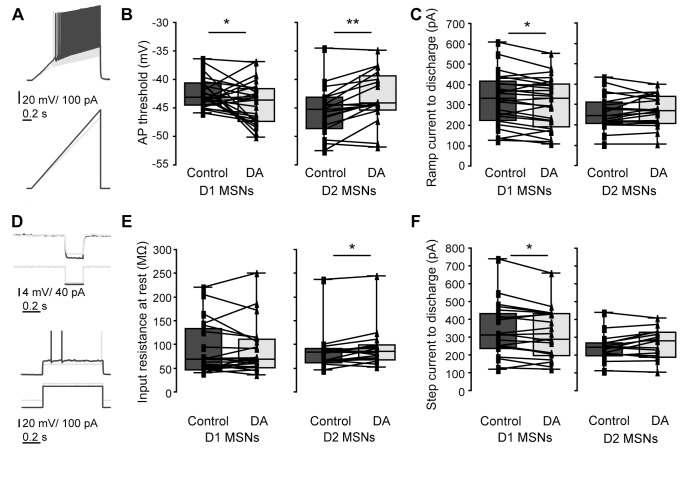
Excitability of D1 and D2 MSNs before and after DA.Excitability of D1 MSNs increases after application of DA (60 µM). A, B, C, excitability as measured by ramp current injections in D1 and D2 MSNs. A, voltage response and APs of a MSN to ramp current injections before and after DA (dark and light gray). B, left panel, box plots showing a decreased AP threshold in D1 MSNs (p = 0.0496). B, right panel, box plot: in D2 MSNs, AP threshold was strongly depolarized after DA (p<0.001). C, left, box plot comparing minimal currents to discharge in D1 MSNs. Significantly less current was needed following DA application (p = 0.017), thus making D1 MSNs more excitable. Right panel: In D2 MSNs, no significant differences in excitability were observed (p = 0.32). D, upper panel, voltage response of MSNs before and after DA (dark and light gray) to small negative step used for extraction of input resistance at baseline membrane potential. Lower panel, voltage responses to minimal suprathreshold current injections. E, box plots showing that input resistance measured from rest remained unchanged in D1 MSNs (left, p = 0.392), and increased in D2 MSNs (p = 0.020). F, box plots showing changes in the minimal step current that initiates discharge. F, left, to bring D1 MSNs to discharge, less current is needed in presence of DA (p = 0.02). F,right, in D2 MSNs no significant differences in excitability by step currents were observed (p = 0.32), consistent with the opposing changes in AP threshold and input resistance shown above. For result details see also Tables 3 and 4.